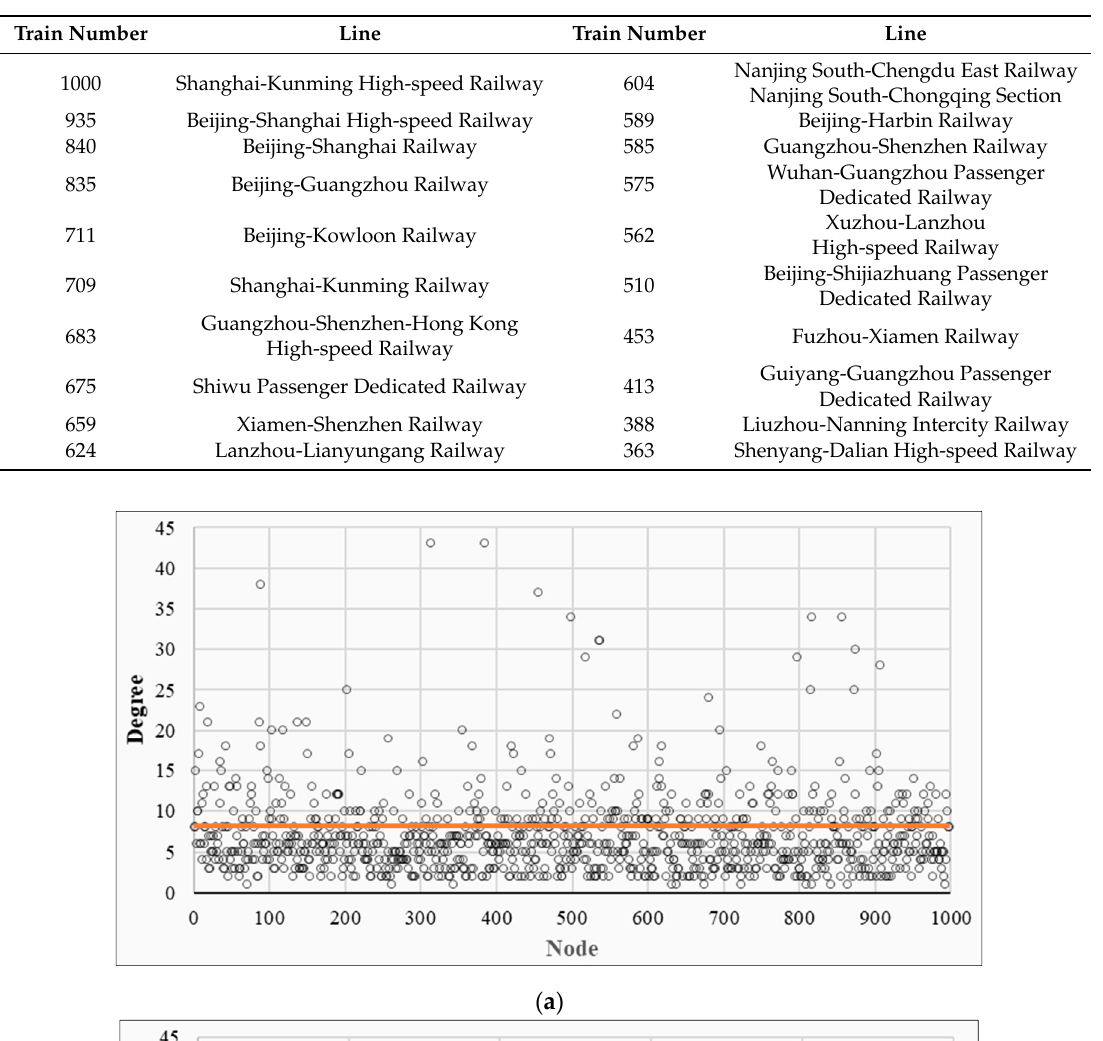
in the geographic network of high-speed railway. The stations with large node degree in the geographic network of normal-speed railway are mainly located in western, central and northeast China. This indicates that these regions still play an important role in the geographic network of normal-speed railway and are important places for construction and renovation of the high-speed railway in the future. As cooperation and connection among regions become closer, it is urgent to improve the high-speed railway between western region and other regions. In addition, Wuhan and Zhengzhou have a larger node degree in both the geographic network of high-speed railway and